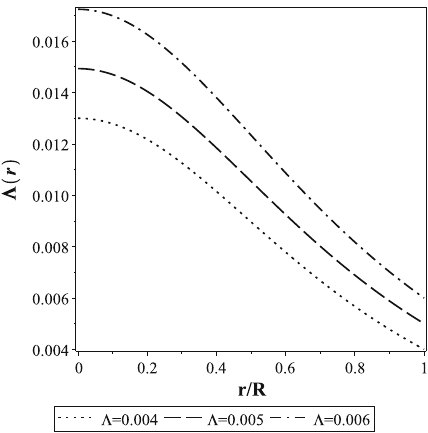
Fig. 3 Behavior of the cosmological constant Λ( r ) as a function of the fractional radial distance for the compact star LMC X − 4 is shown